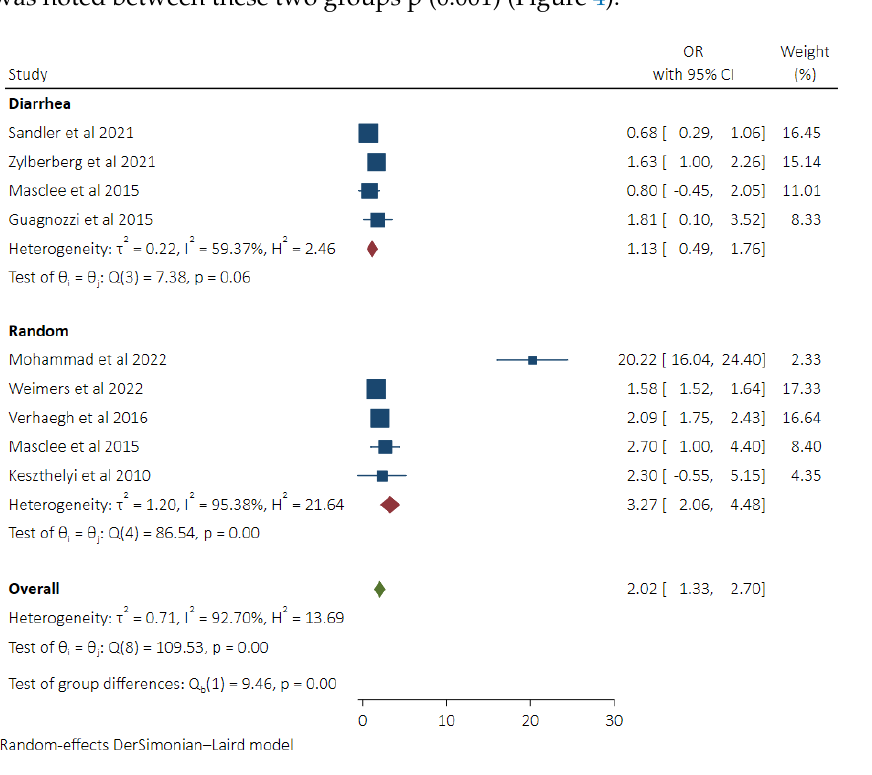
3.6. Pooled Odds of MC in Patients Taking H2RA and Subgroup Analysis Based on Control Groups H2 receptor antagonist use was not associated with increased odds of MC (OR 2.70, 95% CI − 0.32–5.08, I 2 98.67%) based on the data provided in four studies [9,17–19]. Lower odds of MC were seen in patients using H2RA compared to the diarrhea control group (OR 0.46, 95% CI 0.14–0.78, I 2 0%). Similar odds of MC were seen compared to the com- munity control patient population (OR 3.48, 95% CI − 0.41–7.36, I 2 98.89%). No significant difference was seen between the groups ( p 0.13) (Figure